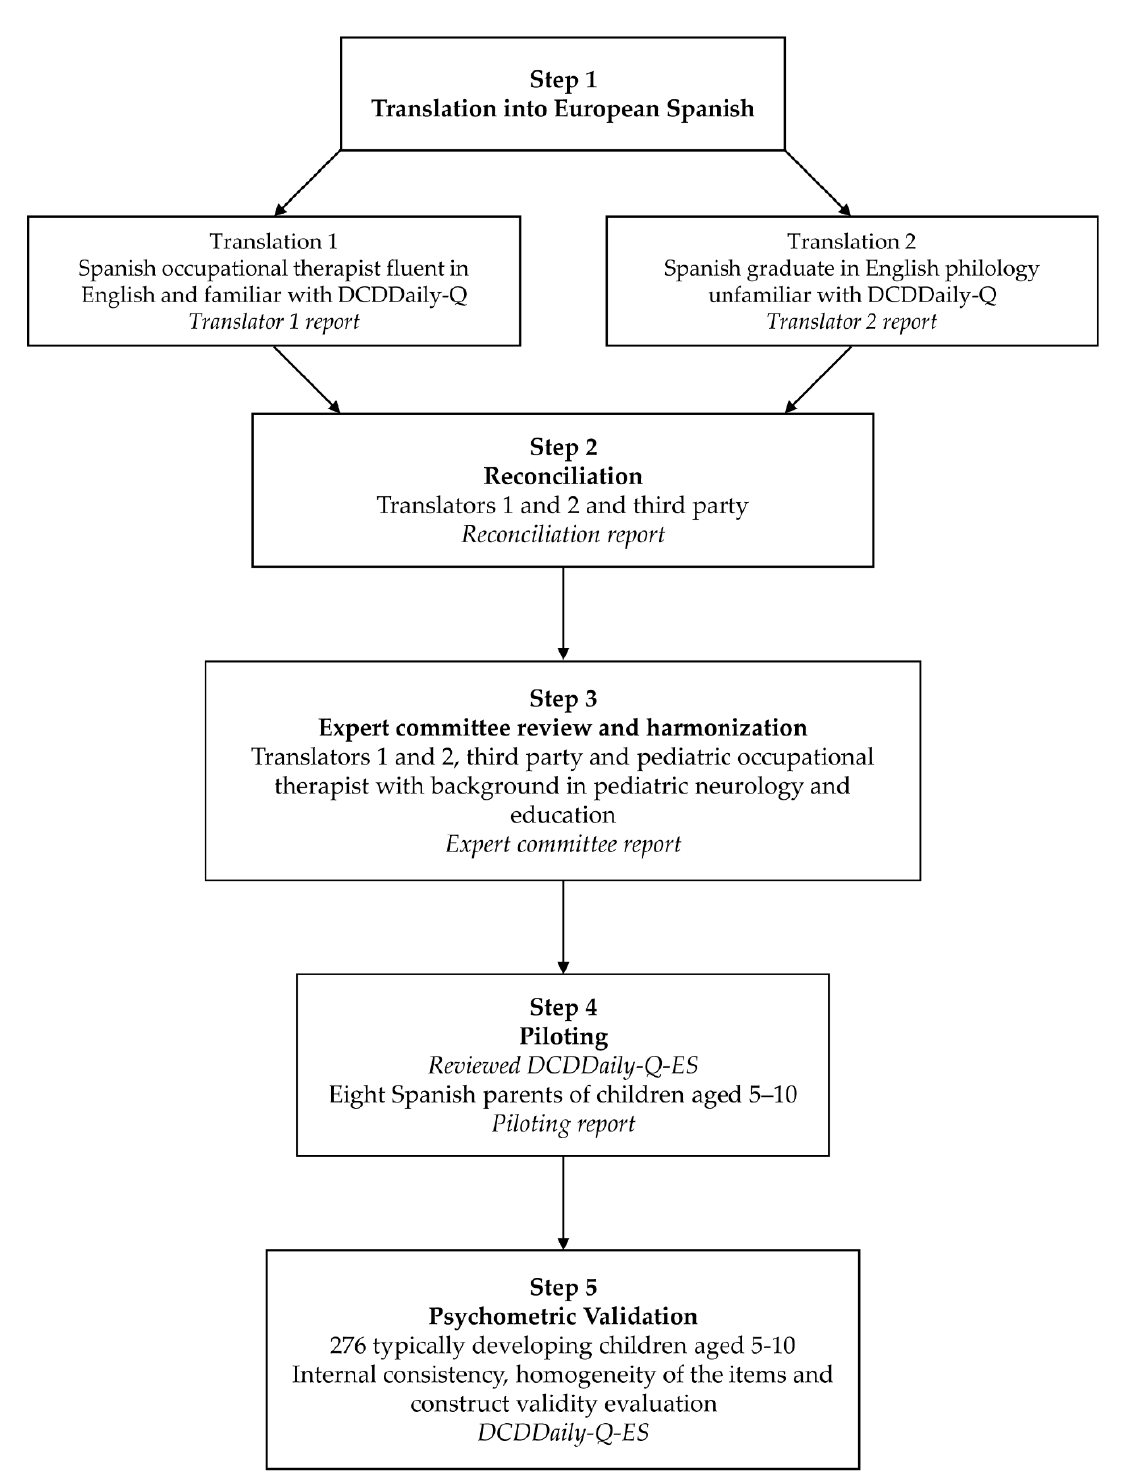
Figure 1. Cross-cultural and psychometric validation process of the Spanish DCDDaily-Q.